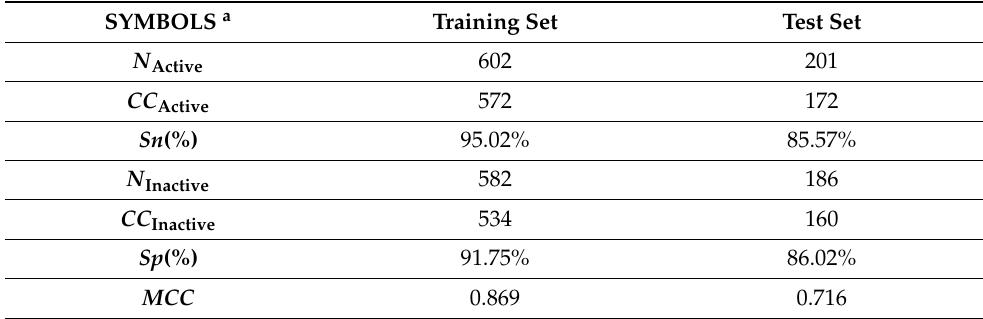
Table 3. Statistical metrics indicating the global performance of the mtc-QSAR-EL model. SYMBOLS